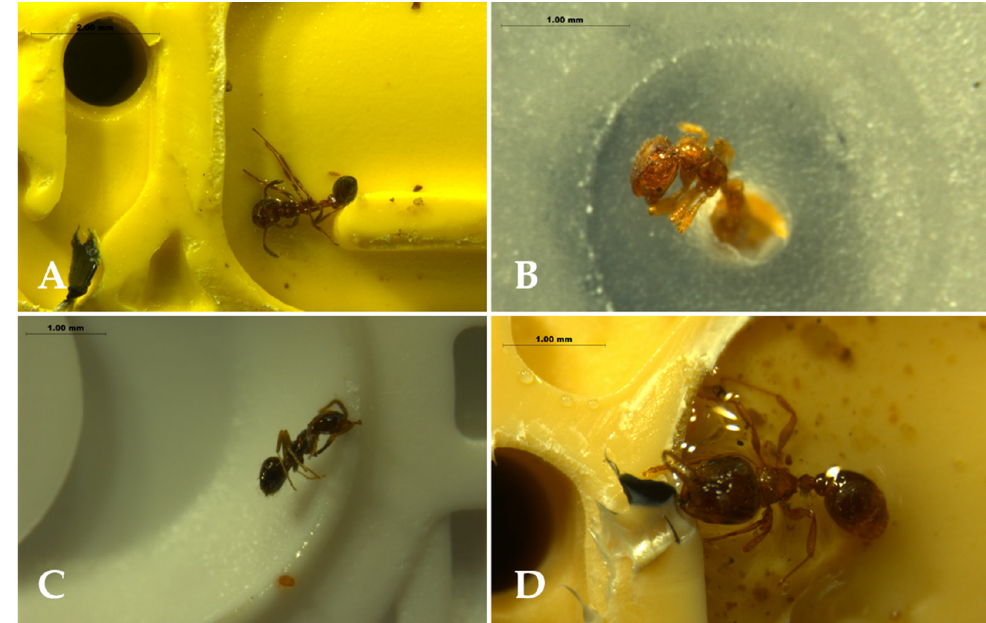
Figure 7. Some examples of ant specimens detected and photographed inside the emitters; ( A ): one specimen of Cardiocondyla batesii located under the outer surface (treatment: ANI); ( B ): one individ- ual of Solenopsis sp. stuck in the inner orifice of the diaphragm (treatment: CEO); ( C ): a specimen of Plagiolepis schmitzii in the inner chamber that surrounds the diaphragm (treatment: EA); ( D ): Tetra- morium semilaeve under the outer surface of a control tube.